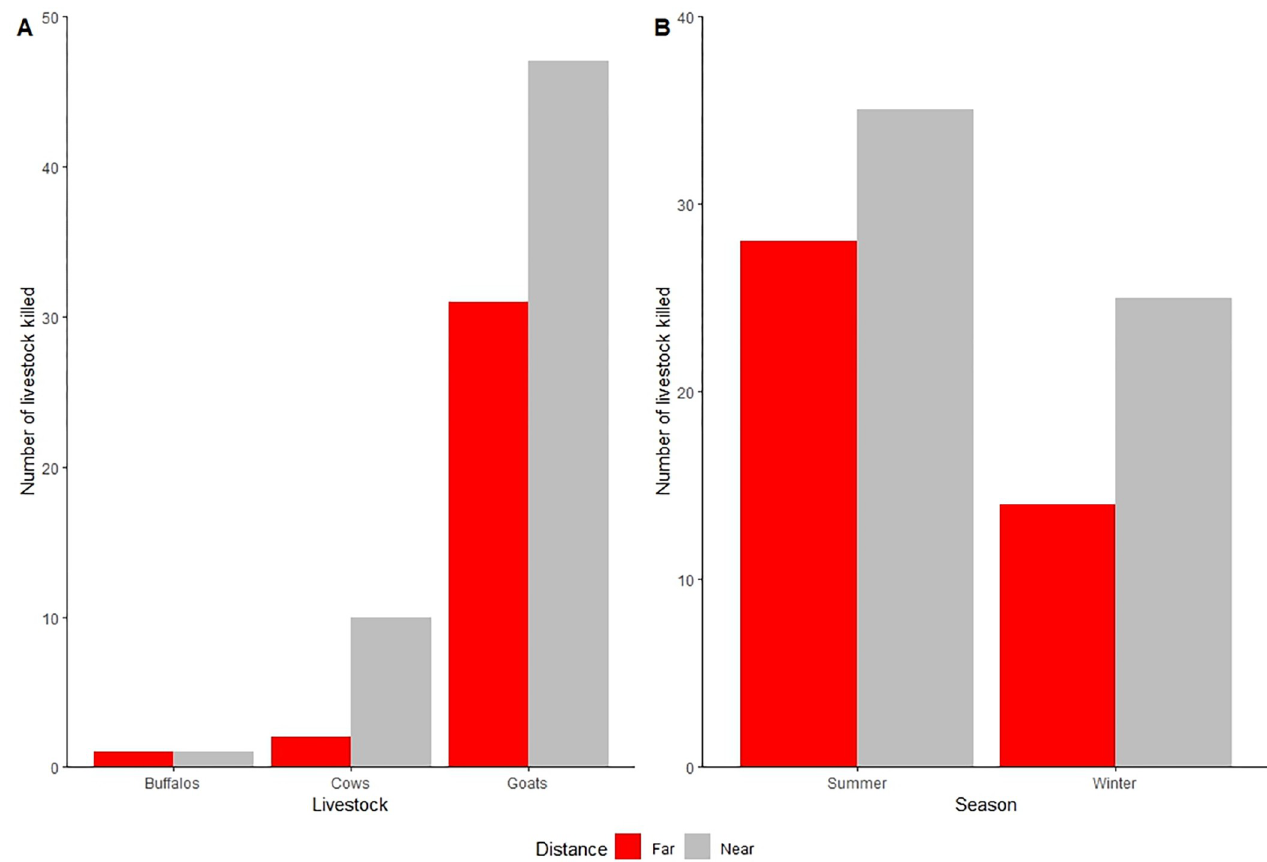
Fig 2. Number of livestock depredation (A); and seasonal livestock depredation (B) near ( < 500 m) and far ( > 500 m) from the Shuklaphanta National Park boundary between 2016 and 2022.